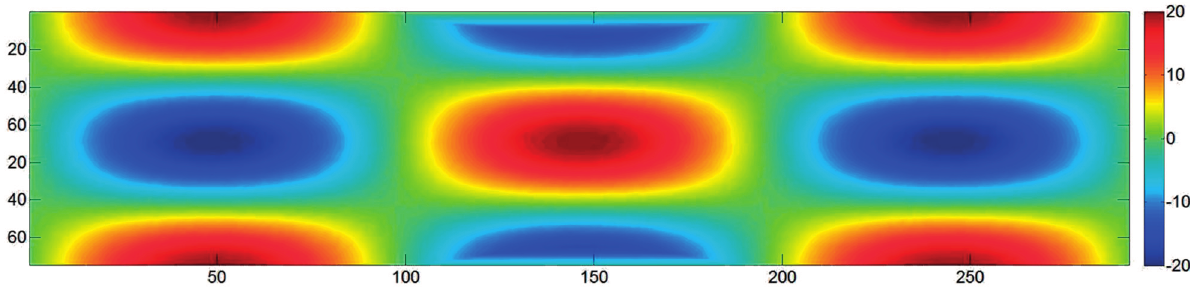
Figure 6. Case 1-B: single strip with four GCP (two on each end), 80% overlap, with self-calibration unbounded. Colour map of the mean error (errors are correlated to the point elevation and reach 20 u